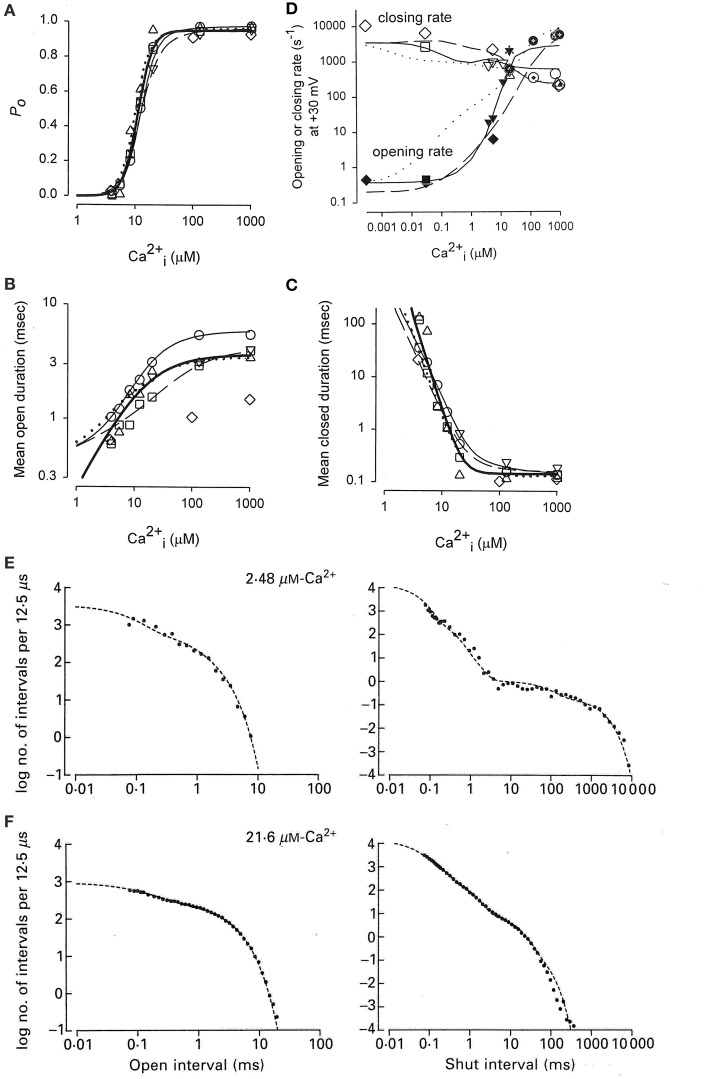
Accounting for the Ca2+ dependent gating of BK channels with Scheme 5. (A) Ca2+ activates BK channels with a Hill coefficient of 3.5 (heavy black line), indicating cooperative action of Ca2+ in opening the channel. (B) Ca2+ increases mean open interval duration with a Hill coefficient of 1.0 (thick black lines) and (C) decreases mean closed interval duration with a Hill coefficient of −3.5. (D) Effective mean opening and closing rates as a function of Ca2+. The major action of Ca2+ binding is to cooperatively increase the opening rate. The thin lines are the description of the data for models based on subsets of the states in Scheme 6 (Rothberg and Magleby, 1999, 2000). (E,F) Predicted dwell-time distributions for Scheme 5 with the two lower left-most open states not included, as they were entered too infrequently to alter the likelihood of the model. Parts A–C are from Rothberg and Magleby (1999). Part D is from Rothberg and Magleby (2000). Parts E and F are from McManus and Magleby (1991). All data at +30 mV.